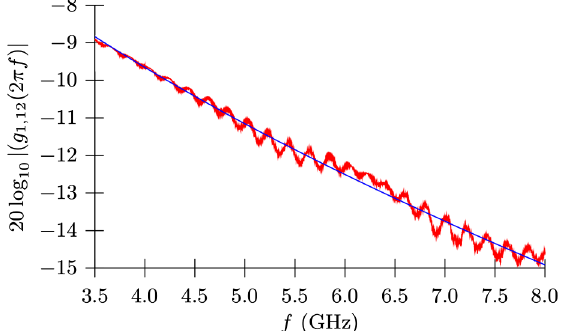
FIG. 10. Measured absolute value of the transmission coeffi- cient of the cable k ¼ 1 (red) and transmission of model cable with the constants ζ 1 and ζ 2 fitted to the measured curve ; 1 ; 1 (blue). The slope of ≈ − 6 dB = GHz reflects the influence of skin effect and dielectric